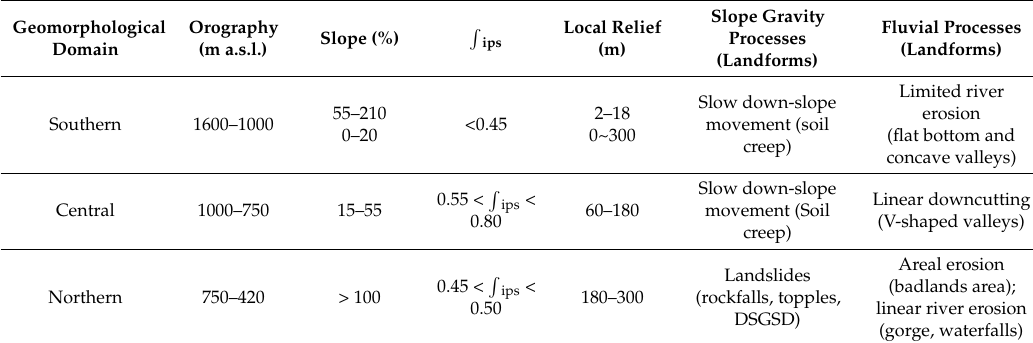
Table 1. Geomorphological domains of Verde Stream catchment